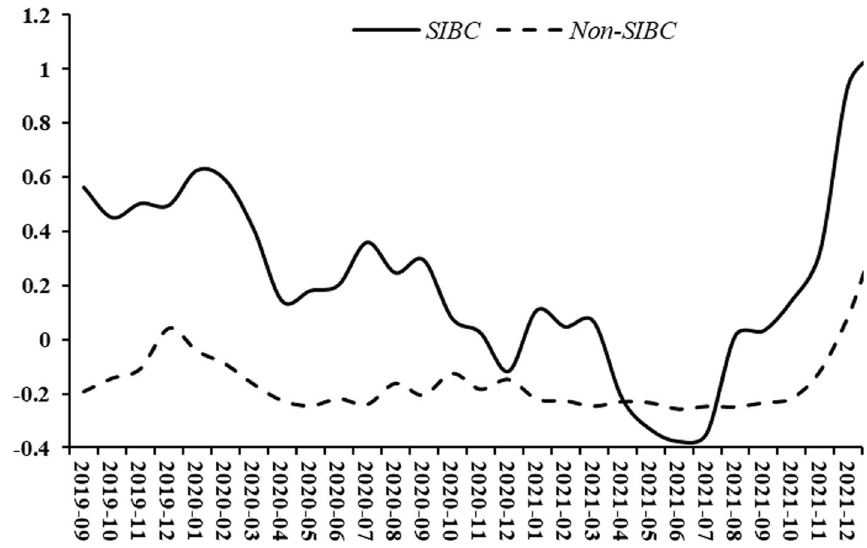
Fig. 1 monthly average pricing deviation rate of SIBC and